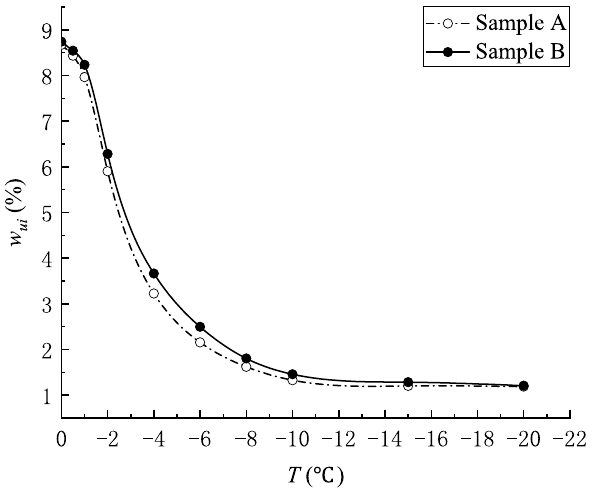
Figure 3. Unfrozen water content—temperature curve during freezing of coal